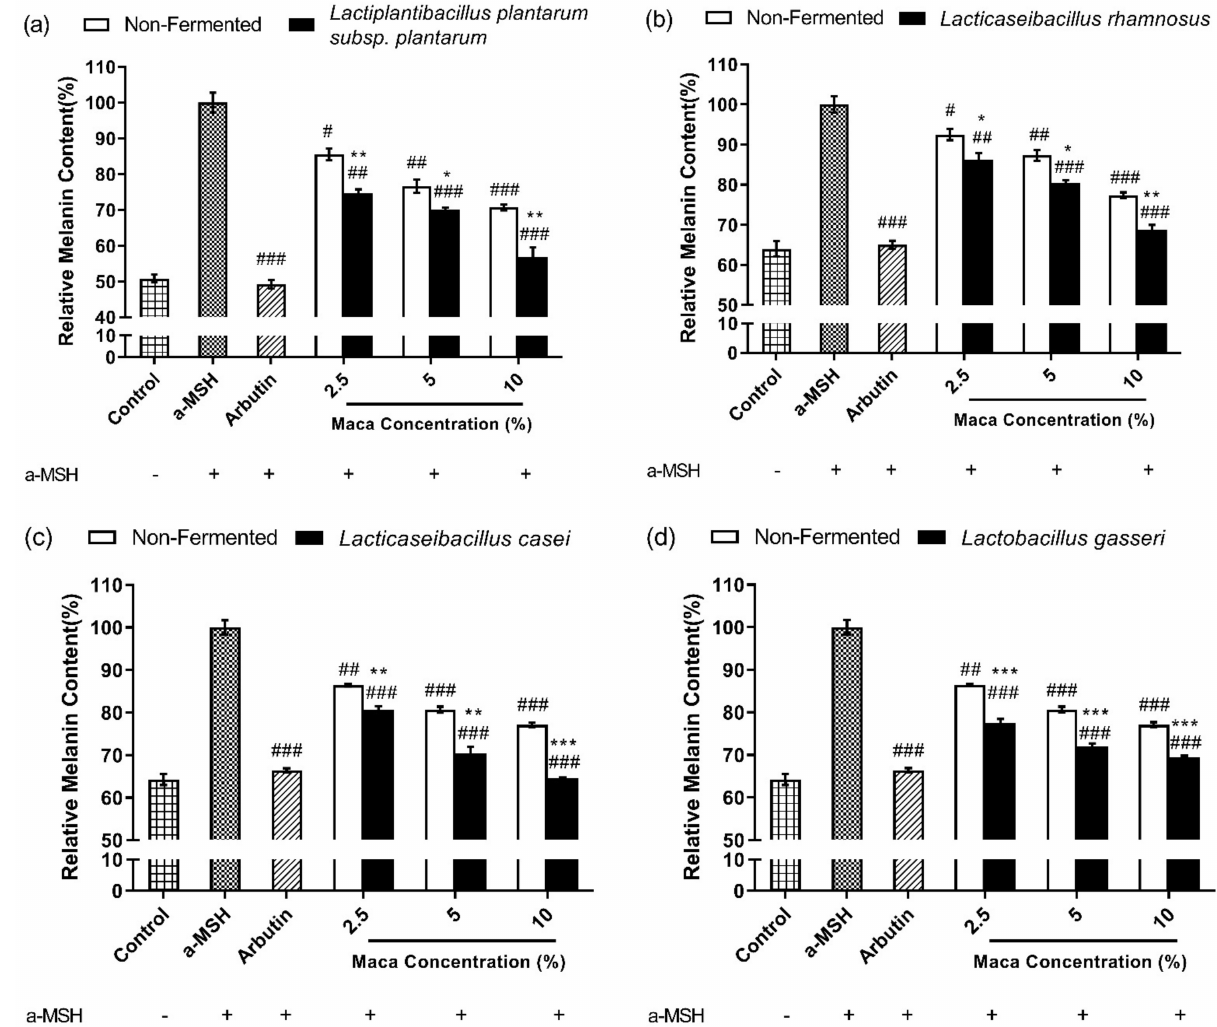
Figure 7. Effect of non-fermented and fermented maca root extracts on intracellular melanin con- tent. Intracellular melanin content of B16F10 treated with maca root extracts fermented using ( a ) Lactiplantibacillus plantarum subsp. plantarum KCTC 3108, ( b ) Lacticaseibacillus rhamnosus KCTC 5033, ( c ) Lacticaseibacillus casei KCTC 3109, and ( d ) Lactobacillus gasseri KCTC 3143. Error bars, mean ± SD. # p < 0.05, ## p < 0.005 and ### p < 0.0005 compared to the α -MSH group, * p < 0.05, ** p < 0.005, and *** p < 0.0005 compared to the same concentration of non-fermented maca root